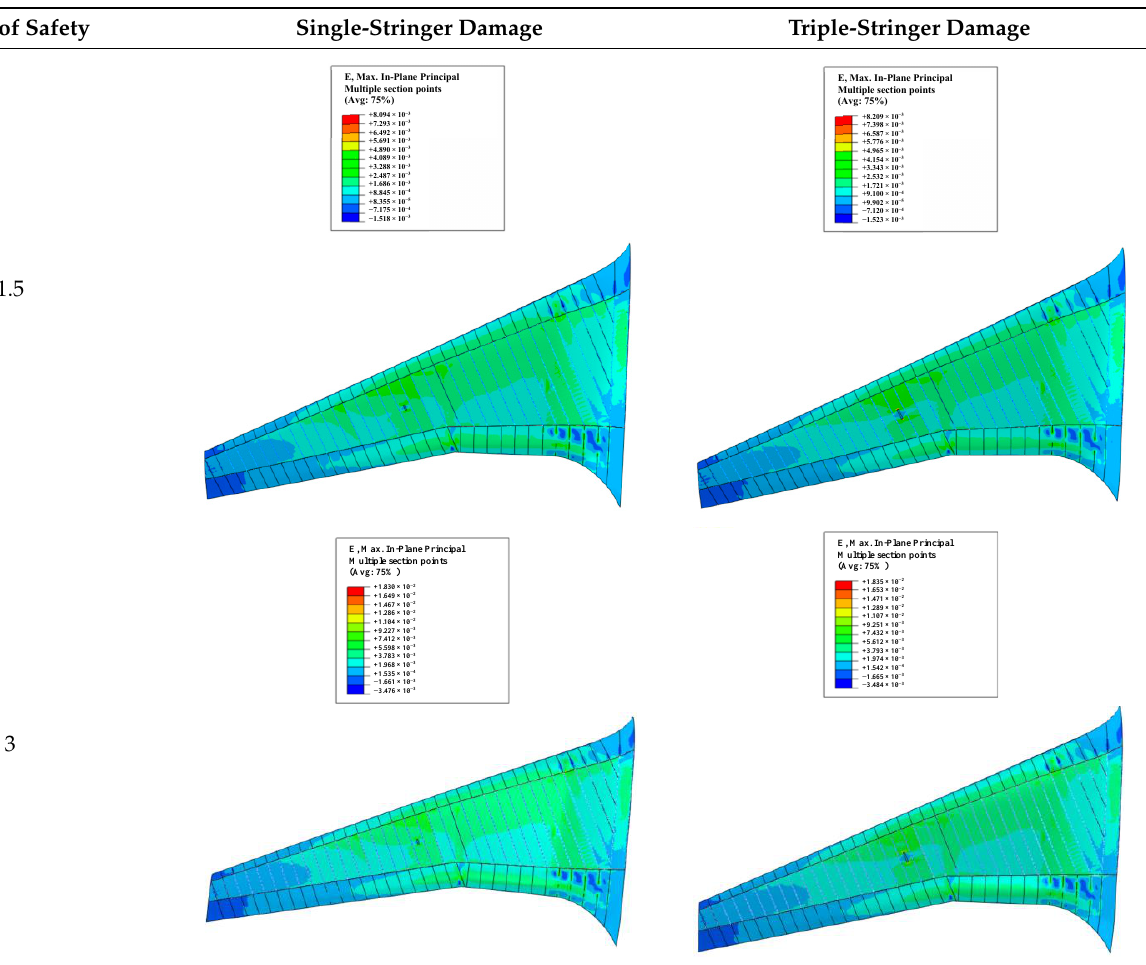
Table 7. Results of the maximum in-plane principal strain of single-stringer and triple-stringer damage BWB wings at different values of F.o.S.